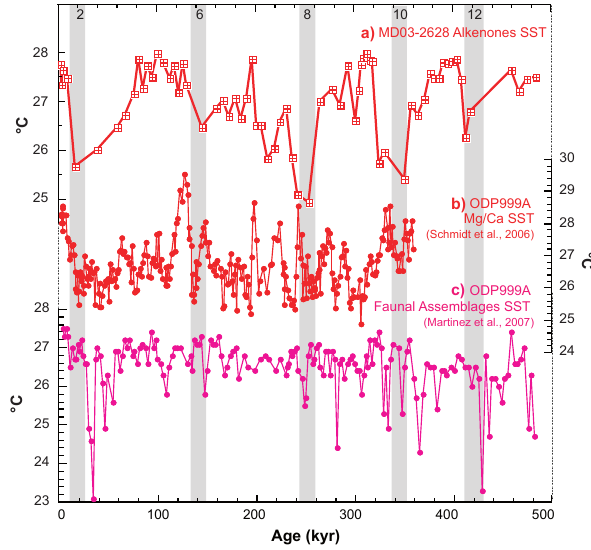
Fig. 5 Fig. 5. A comparison of the MD03-2628 sea-surface temperature (SST) record with other SST reconstructions in the Caribbean Sea. (a) A zoom-in for the last 500ka for the SST results obtained using 0 the U K index on core MD03-2628; (b) and (c) results obtained on 37 ODP core 999A (Fig. 1a) by (b) Schmidt et al. (2004 and 2006a), with Mg/Ca SST results (red curve and dots) and by (c) Martinez et al. (2007), with mean annual values of faunal SST reconstructions (pink curve and dots). Light gray bars and even numbers are the same as in Fig.